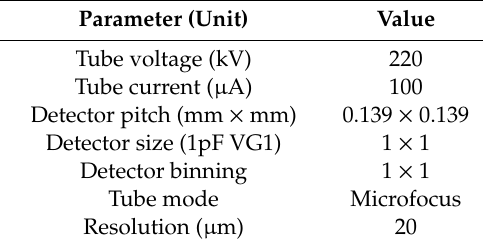
Table 3. XCT parameters used for the target